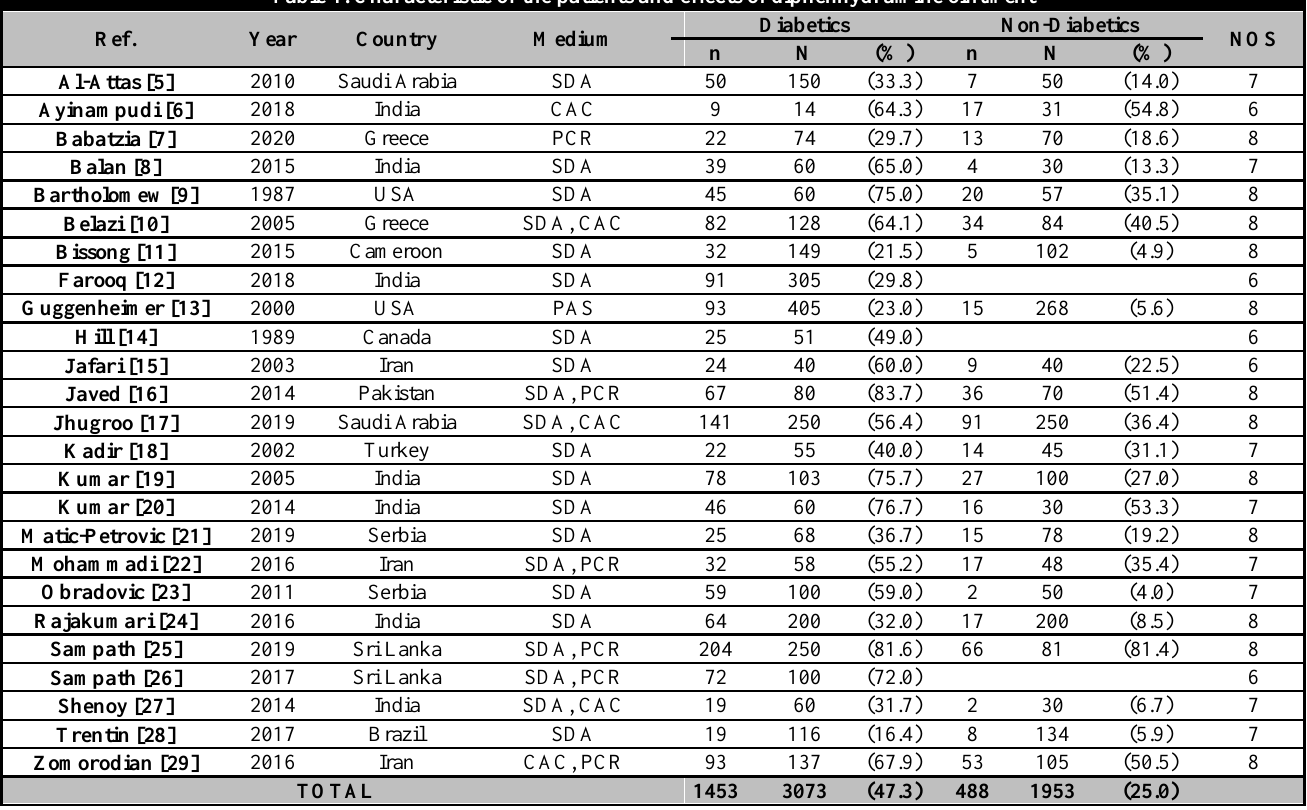
Table 1. Characteristic of the patients and effects of diphenhydramine ointment